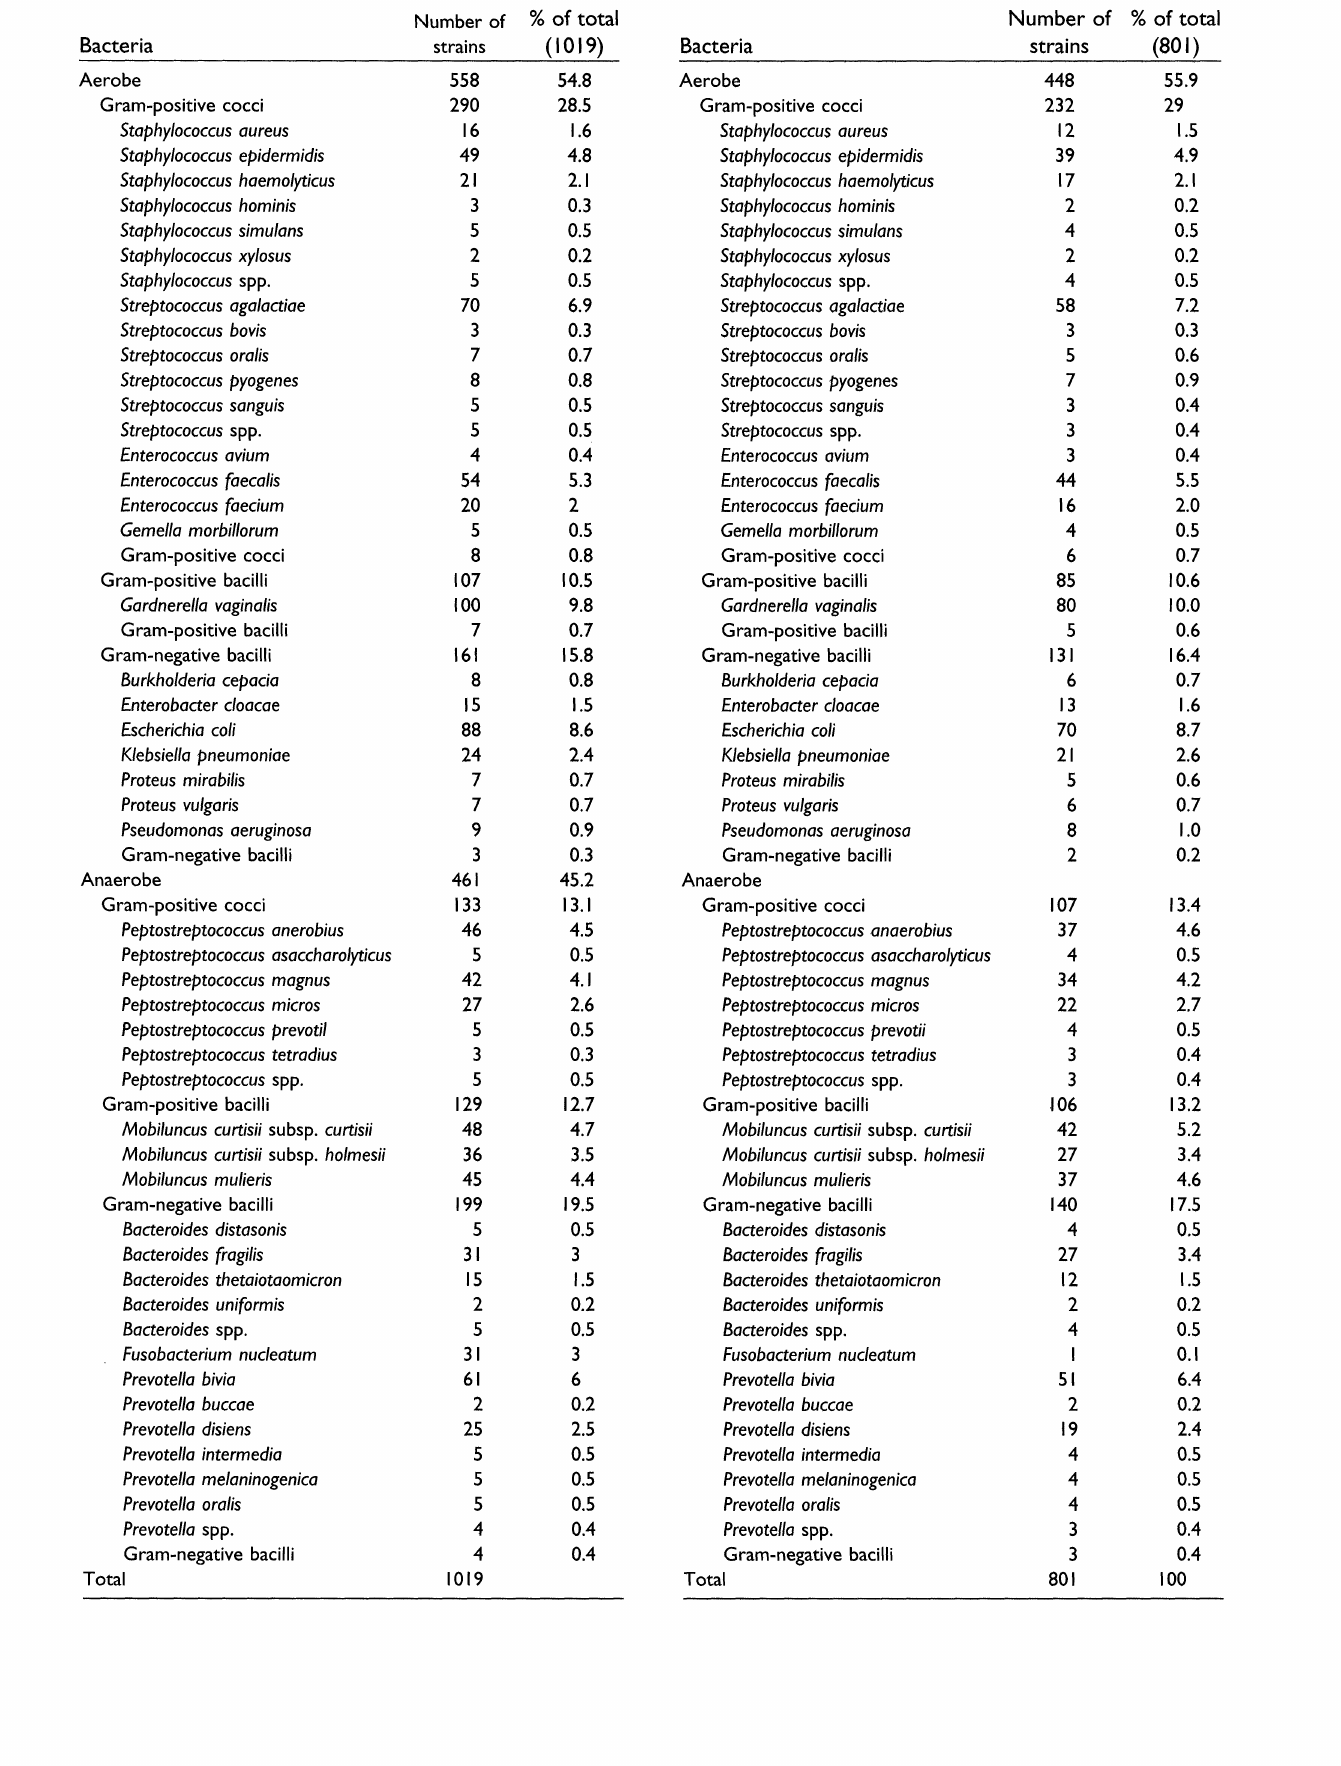
TABLE 4. Organisms detected from the patients with preterm